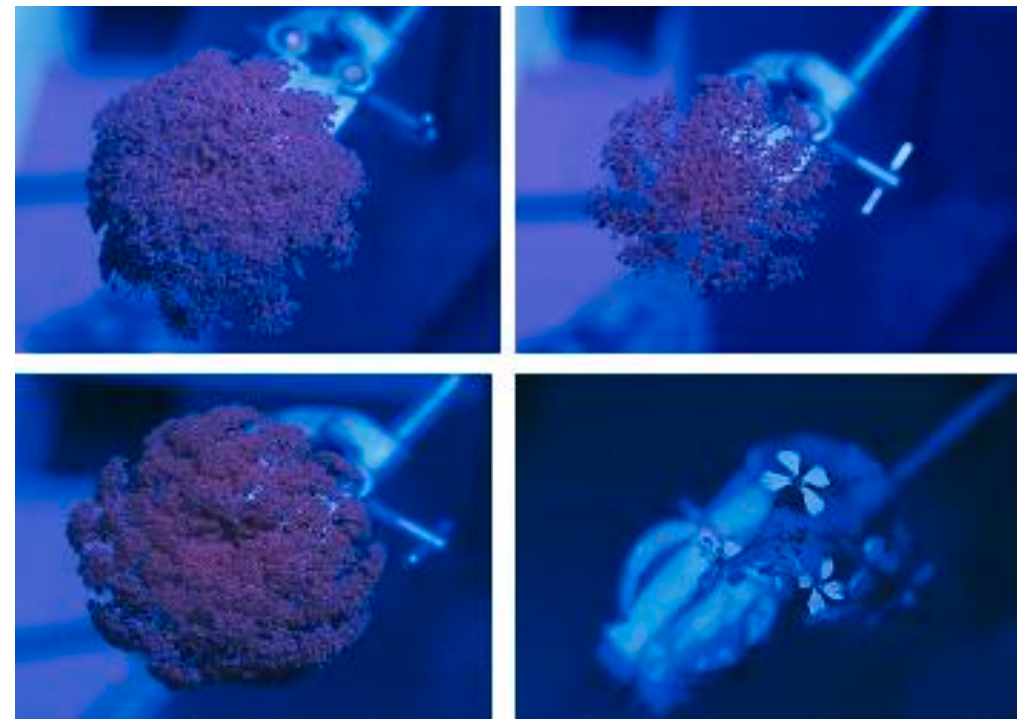
Figure 3. Comparison of ultraviolet reflectance of Daucus carota (3 replicates) vs. Raphanus raphanistrum (wild radish)—bottom right—when photographed under field conditions. Ultraviolet reflectance appears white.